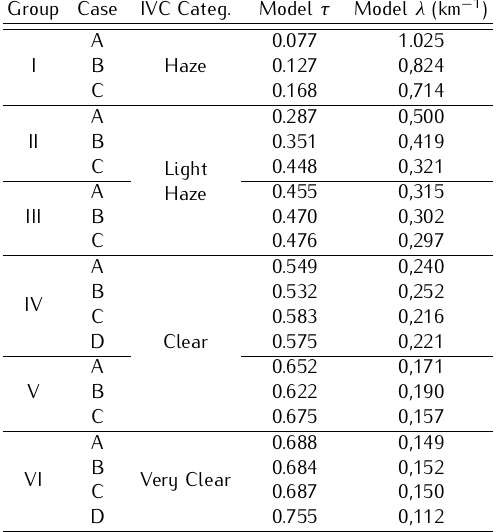
SR with γ values predicted or measured at a different SR . Although this appears as a limitation of the ESLM model for practical applications, for all SR considered we determined from NIR-camera energy measurements and γ using Equation (69), and compared the calculated values with the experimental results. Therefore, for each SR , different sets of corrections were computed simply by comparing the predicted ESLM τ and γ values with the experimental data. Since the initial phases of the test activity, data collected in various meteorological con- ditions and with various laser slant-paths, demonstrated moderate discrepancies between the extinction measure- ments performed with EMT-1 and EMT-2 ( i.e. , 8% maximum difference). Furthermore, using the two techniques, no sig- nificant correlation was observed between the differences in the measurements and the lengths of the laser slant-paths used to gather the experimental data. Table 12 shows the results of transmittance measurements performed us- ing the EMT-2 technique for a laser slant-path of 2.5 km, compared with ESLM model